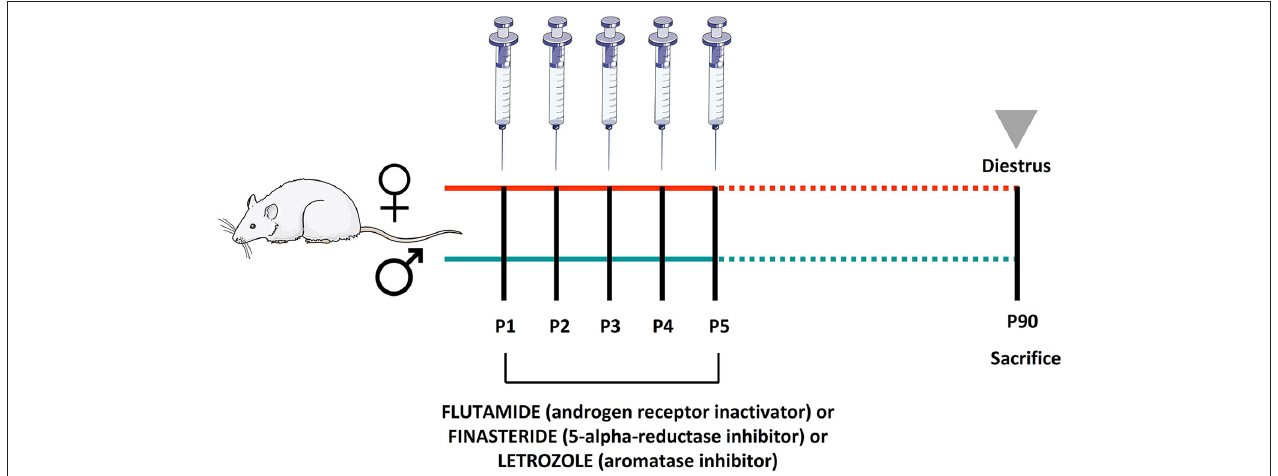
FIGURE 1 | Schematic diagram of the experimental setup: male and female pups were treated during the first five postnatal days with flutamide, a selective androgen receptor inactivator, or finasteride, a selective 5 α -reductase inhibitor, or letrozole, a selective aromatase inhibitor. Animals were sacrificed at the postnatal day